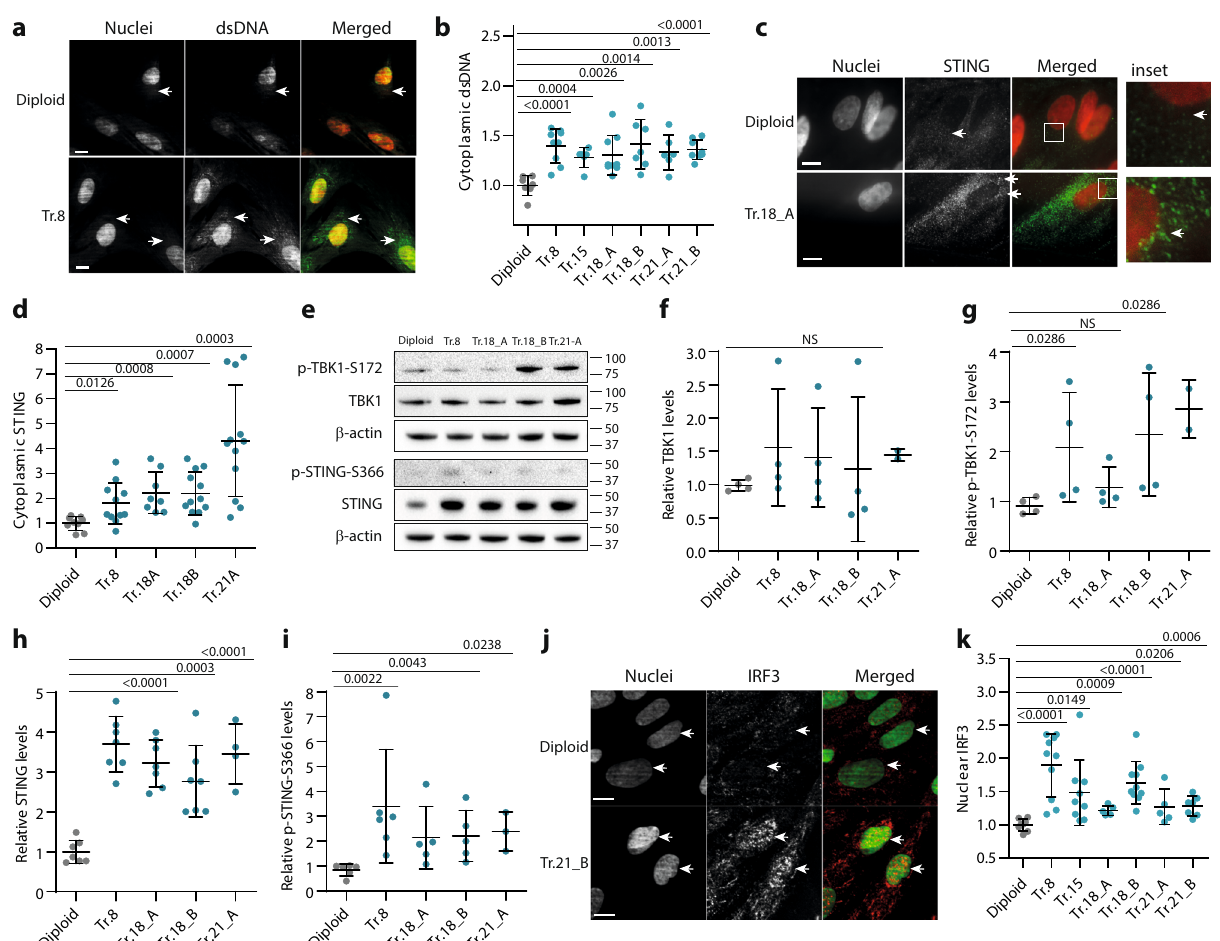
Fig. 7 Innate immune response is activated in primary fi broblasts with trisomy. a Examples of immuno fl uorescence images of nuclear and cytoplasmic dsDNA. White arrows point to the dsDNA-positive signal outside of the nucleus. b Quanti fi cation of the relative intensity of cytoplasmic dsDNA signal. At least 700 cells were analyzed in each experiment, 6 – 9 experiments were performed in each cell line, and means of individual experiments are plotted. Delta MFI data for the cytoplasmic dsDNA were calculated as the difference between the signals from the total cellular area and the nuclear area; plotted are data normalized to the diploid controls. c Immuno fl uorescence images of STING. White arrows indicate the STING-positive clusters. d Quanti fi cation of the cytoplasmic STING intensities, calculated similarly as in b . In total, 100 cells were analyzed in each experiment, means of each experiment are plotted, and 8 – 12 experiments were performed for each cell line. e Immunoblot showing total and phosphorylated levels of TBK1 and STING proteins and its relative quanti fi cation. f – i In total, 3 – 7 experiments were performed in each cell line. j Localization of IRF3 in primary fi broblasts. White arrows point to the nuclei with a strong nuclear IRF3 signal in trisomic cells. k Quanti fi cation of the relative IRF3 nuclear localization. At least 1400 cells were analyzed in 5 – 10 independent experiments, means of each experiment are plotted. Delta MFI data for the nuclear IRF3 were calculated and normalized to the diploid controls. Unpaired two-tailed t -test was used for statistical analysis; f , g , i were analyzed with Mann – Whitney test. Individual measurements, mean and p - values, and standard deviations are shown in the plots; statistical evaluation is summarized in Supplementary table 4, source data is available in Supplementary Data 5. Scale bar 10 µ